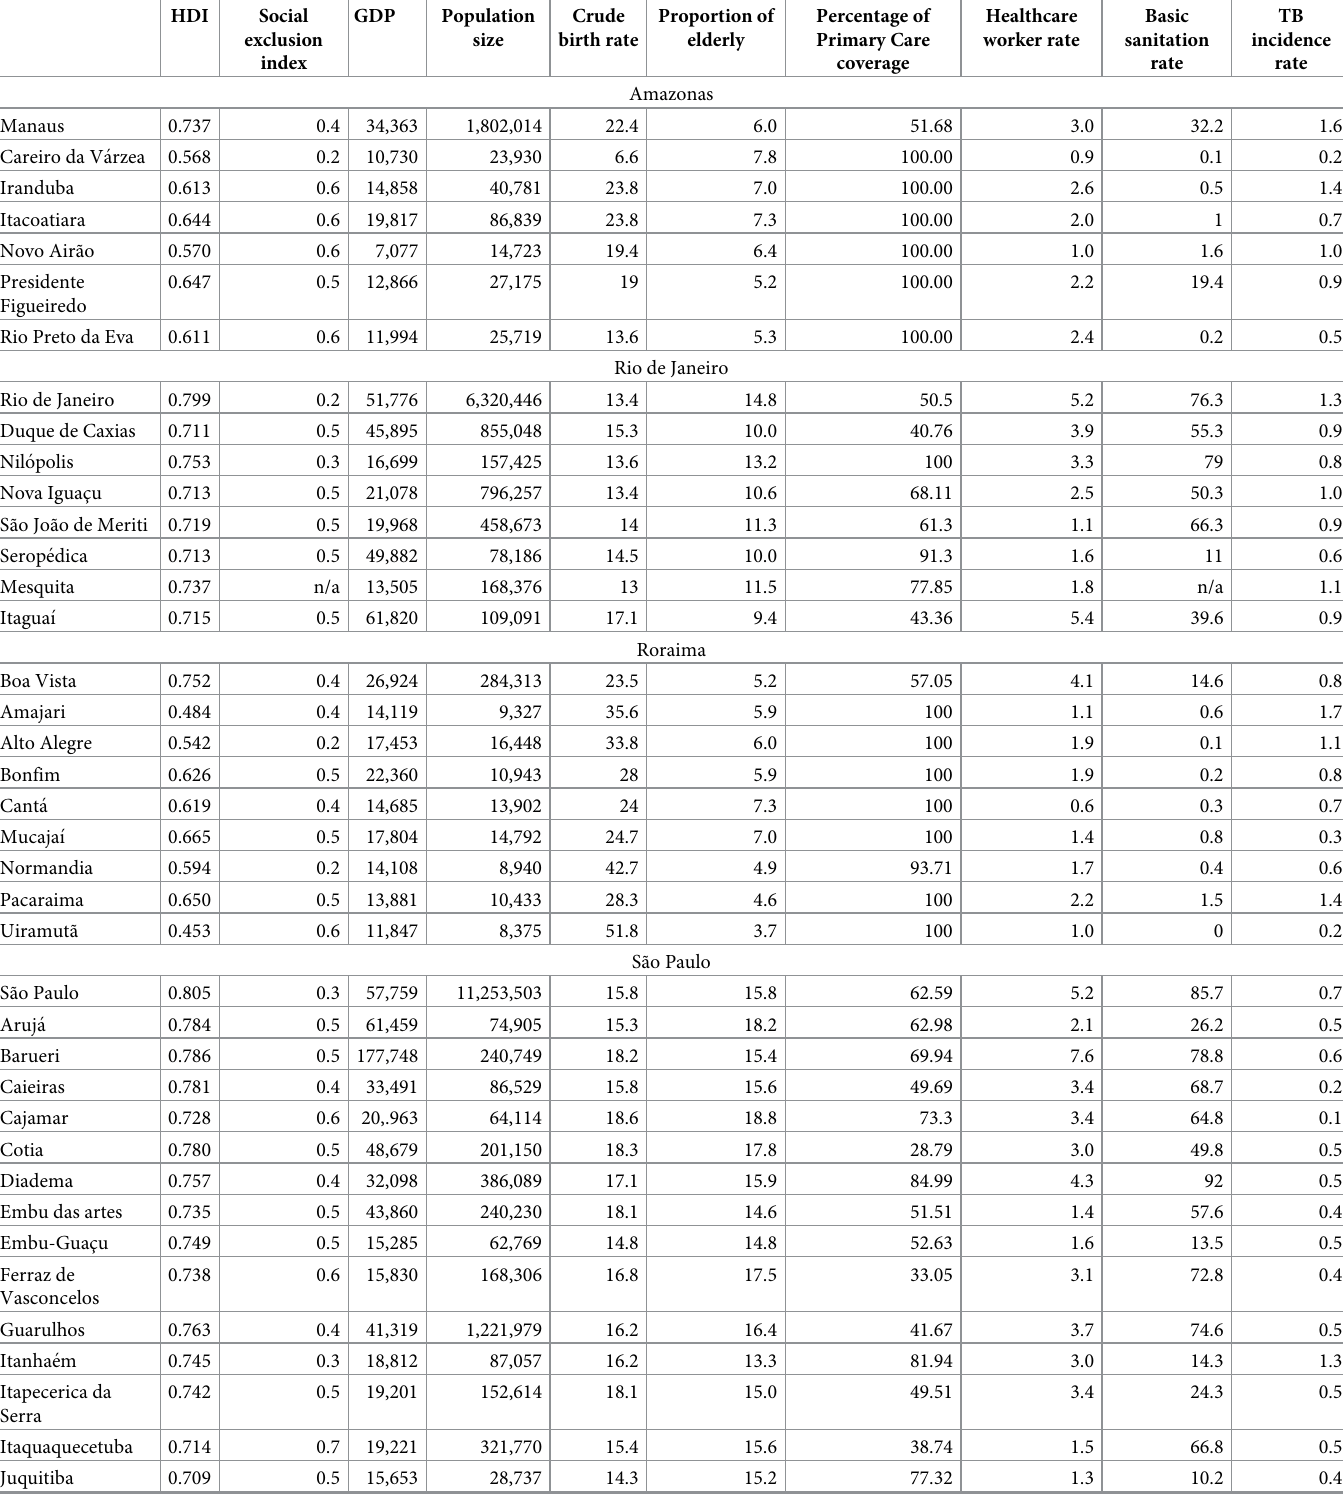
Table 3. Characteristics of social and health determinants in the municipalities with tuberculosis clusters in migrants, Brazil (2014–2019).